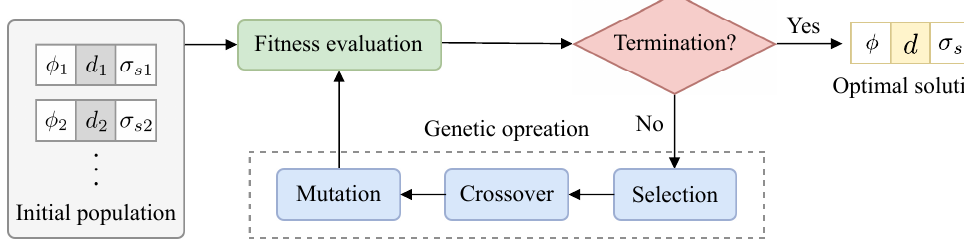
Figure 4. Outline of the genetic